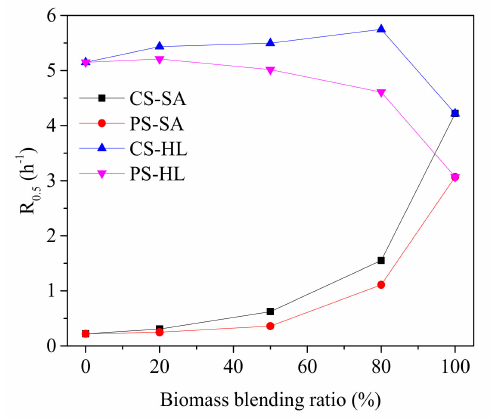
Figure 7. Reactivity index of char samples with different mass ratios at 900 ◦